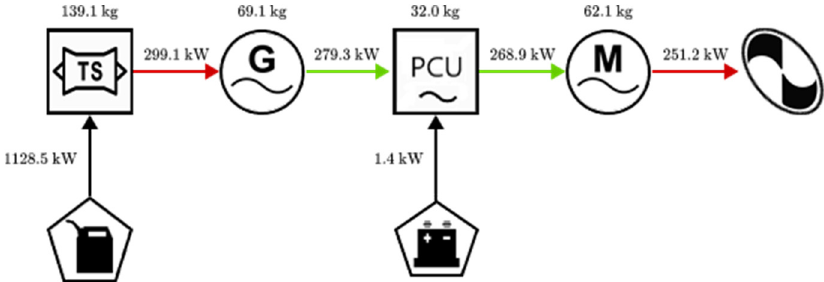
Figure 14. Power and mass distribution of General Aviation case study. Table 6. Mission specifications.